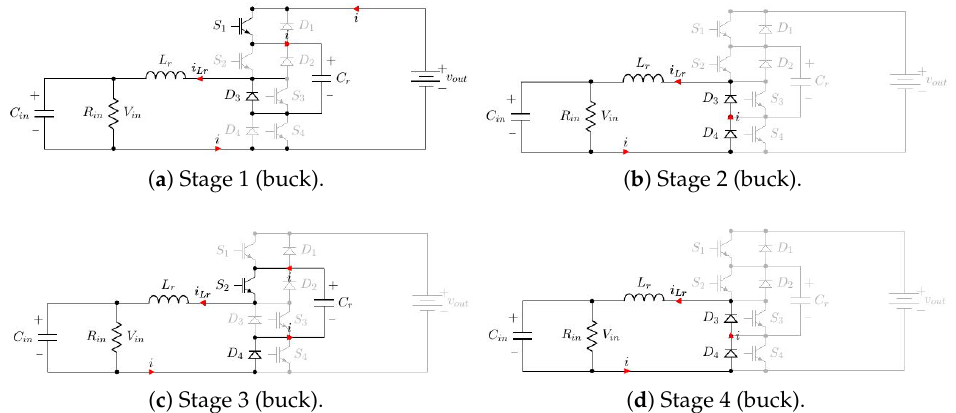
Figure 9. Representation of the buck topological